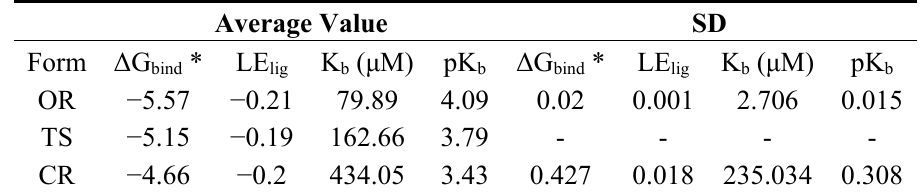
Table 1. Statistics of molecular docking results for open-ring (OR), transition state (TS), and closed-ring (CR) forms of midazolam formulated with TRIMEB.